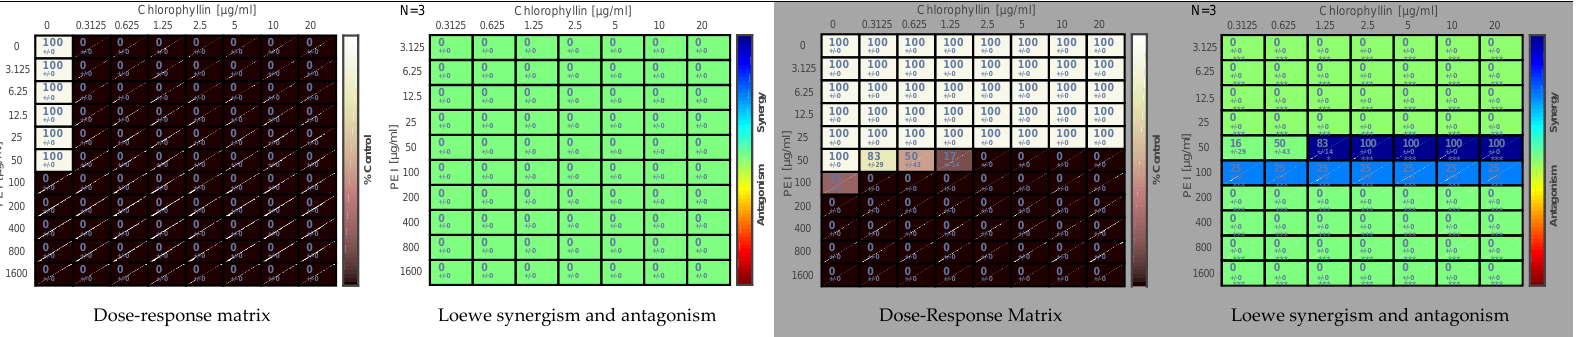
Figure 1. Effect of PEI and chlorophyllin combinations on Salmonella enterica serovar Typhimurium upon illumination with a blue-red light source (12.7 mW cm −2 ) and in darkness at 0 min, 60 min, 120 min, and 240 min of incubation. The dose-response matrix indicates the percentage of eradication (the darker the color, the higher the inhibitory effect). The Loewe synergism and antagonism for PEI-chlorophyllin combinations against S. enterica serovar Typhimurium were determined using the Combenefit software. N represents the number of biological replicates in the matrix. Asterisks represent statistical significance: *: p < 0.05, **: p < 0.01 and ***: p < 0.0001.